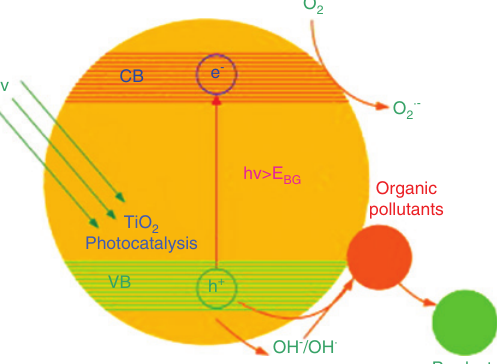
Figure 6: Schematic illustration of the processes by illumination on TiO , photo-generating of hole-electron pair, and resumption of the 2 mechanism for the photo-degradation of pollutants and hazardous compounds. Reprinted with permission from Ref. [61]. Copyright 2012 Elsevier.